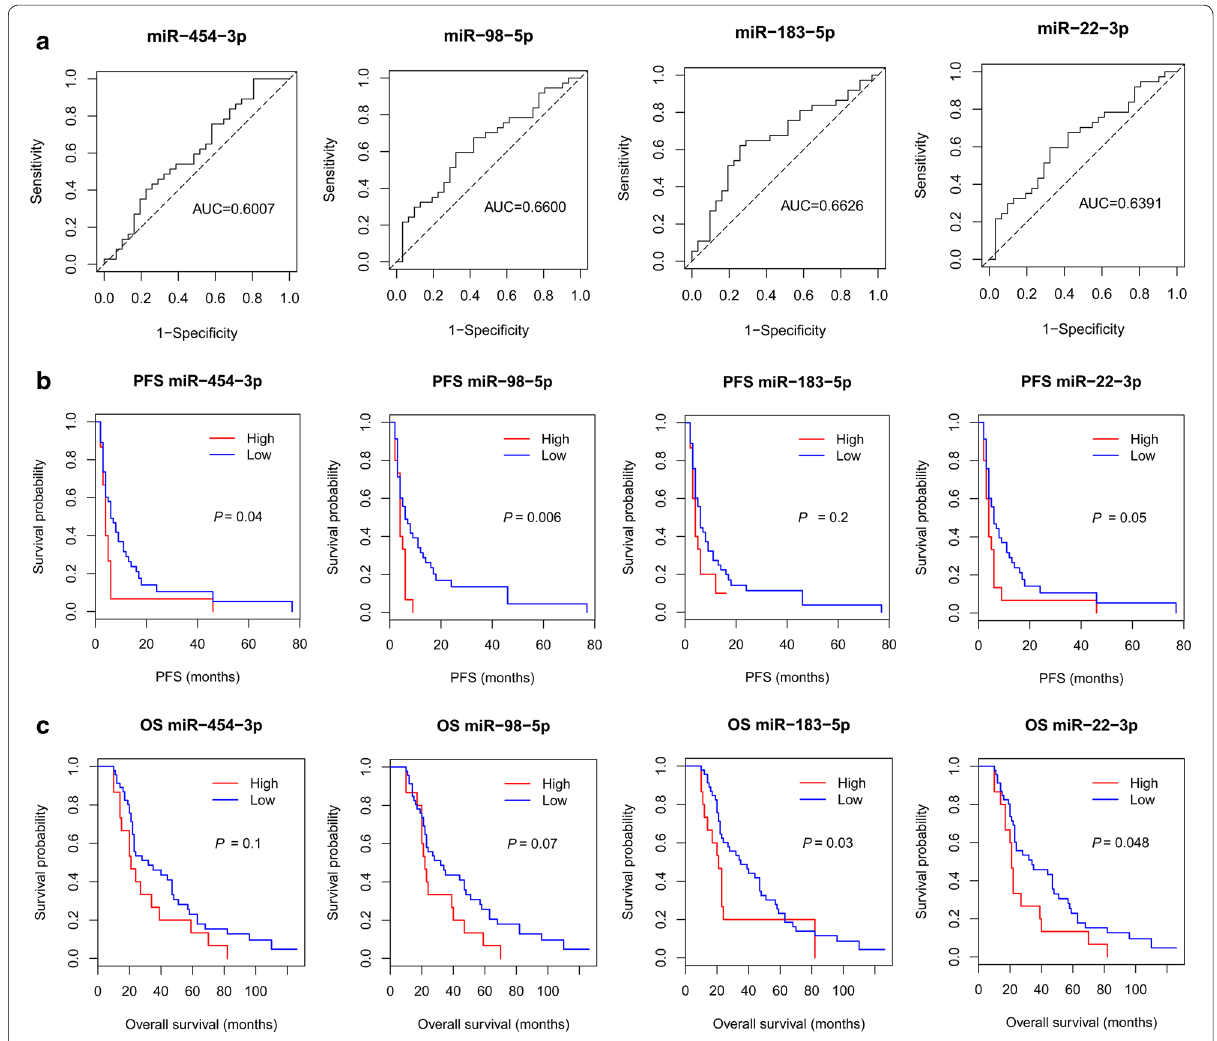
Fig. 3 Prognostic performance of the identified miRNA biomarkers evaluated based on ROC curve and Kaplan–Meier survival analyses. a Sensitivity and specificity of miRNA biomarkers in predicting platinum resistance in HGSC were assessed by ROC curve analysis and AUC values. The dashed diagonal line in the ROC plot refers to AUC 0.5, which means discrimination with random chance. b , c Kaplan–Meier survival curve analyses for = progression-free survival (PFS) ( b ) and overall survival (OS) ( c ) of HGSC patients were conducted to evaluate the prognostic performance of miRNA biomarkers in predicting survival times. P -values were calculated using the log-rank